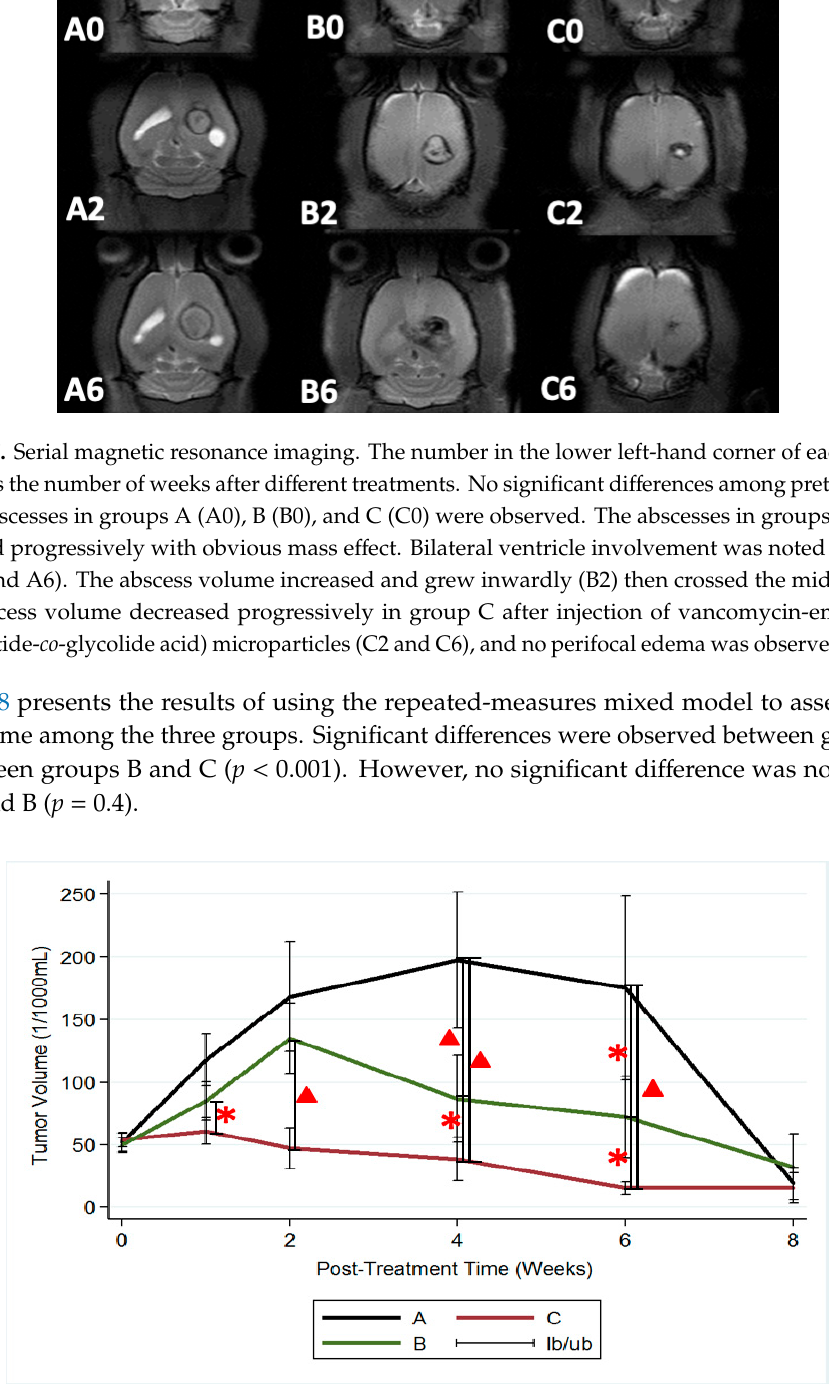
Figure 8. Brain abscess volumes. A repeated-measures mixed model was used to evaluate the brain abscess volume changes in the three groups. Brain abscess volumes in groups A and B increased rapidly and were significantly greater than those in group C, with differences reaching significance (group A vs group C, p < 0.001; group B vs group C, p < 0.001). ( ▲ : p < 0.01; ＊ : p < 0.05)